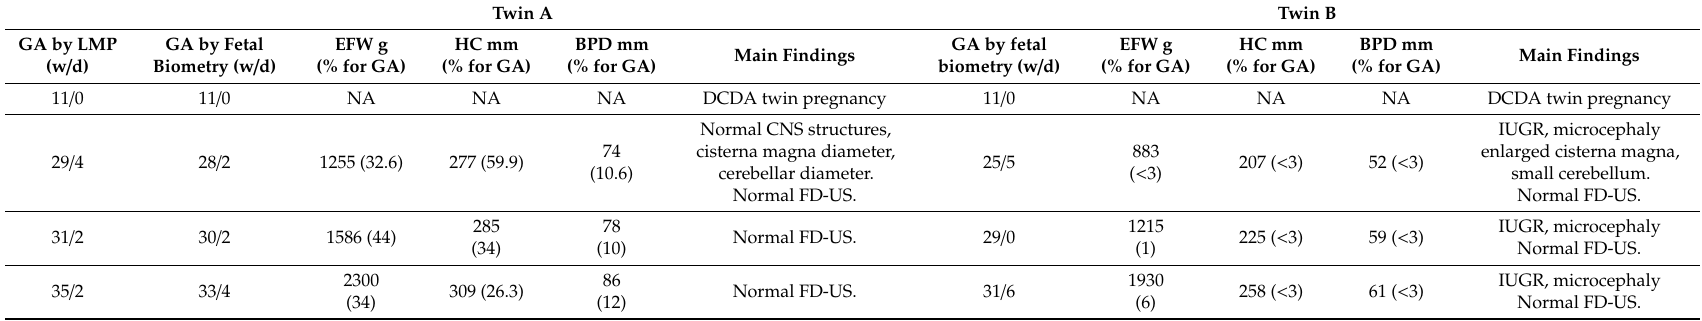
GA by fetal EFW g HC mm BPD mm Main Findings biometry (w / d) (% for GA) (% for GA) (% for GA) NA NA